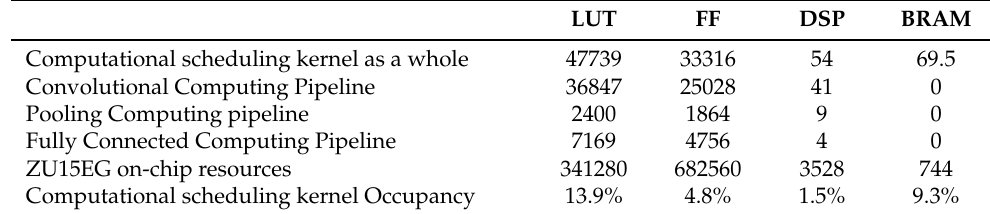
Table 2. Computational scheduling kernel resource